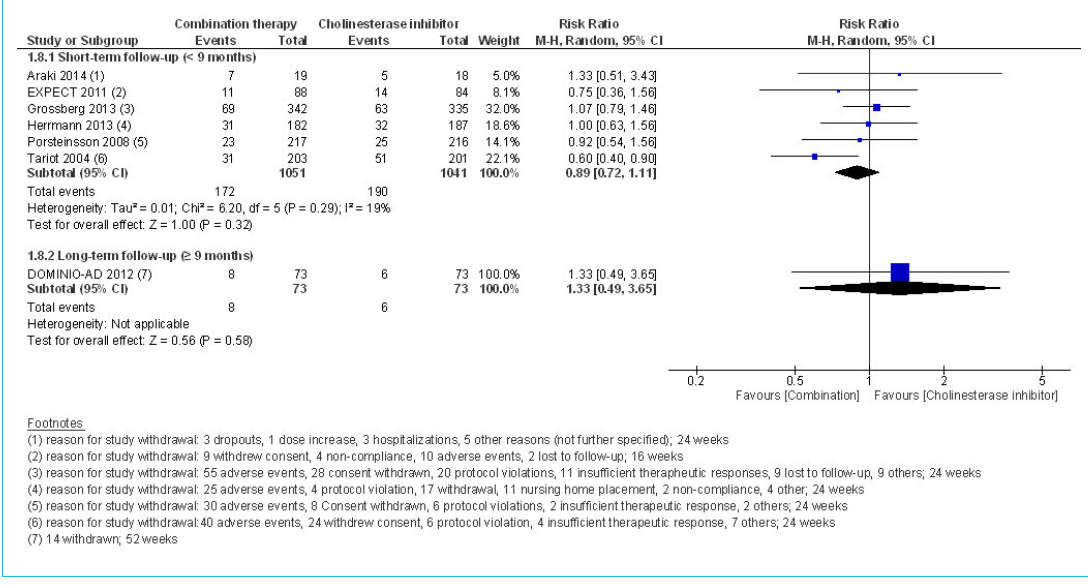
Figure 7: Withdrawals from